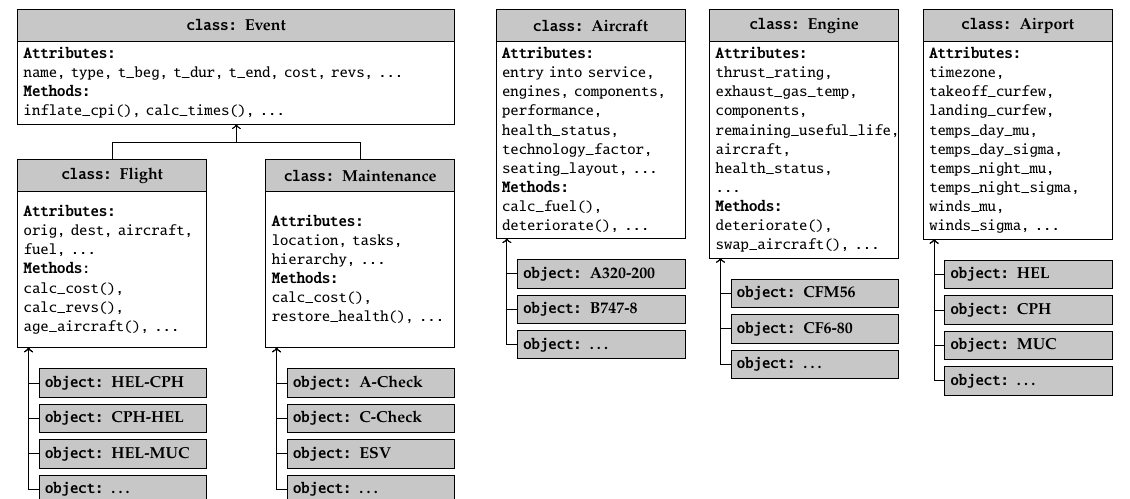
Figure 4. Excerpt of available classes and their attributes and methods in (Air)LYFE.